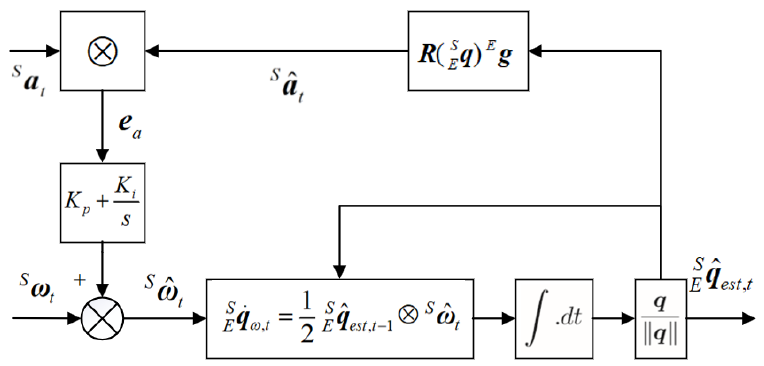
Figure 4. Block diagram of complementary filter for gyroscope and accelerometer.